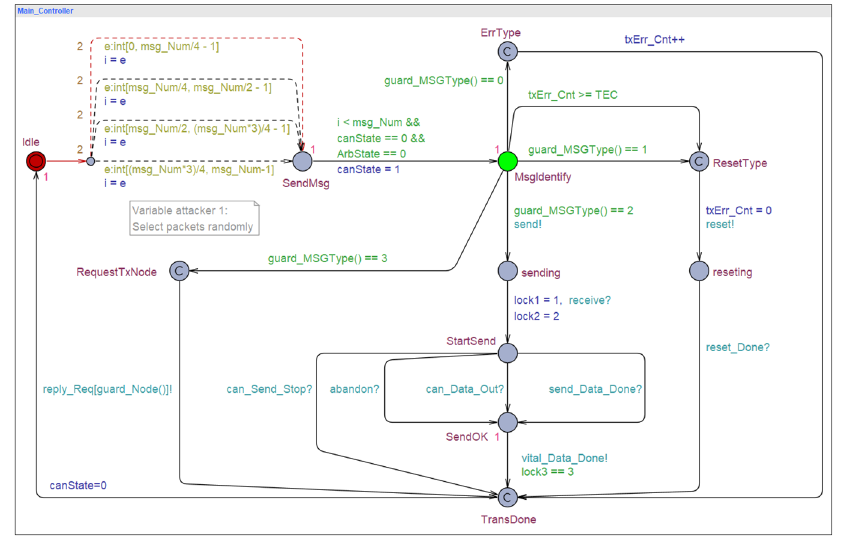
Figure 6. Timed automata (TA) of the master on the CAN bus: Main_Controller.